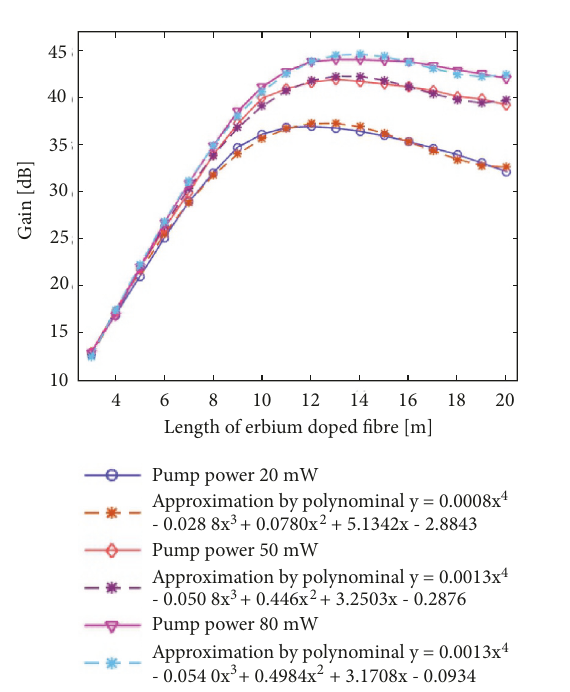
Figure 2: Length of Erbium-doped OF to EDFA gain.